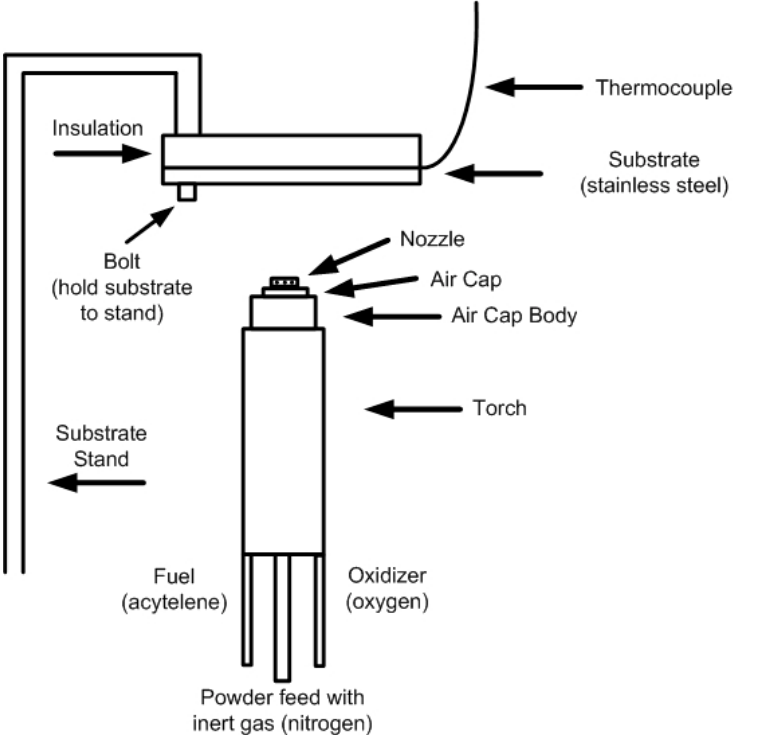
Figure 2. Schematic diagram of the experimental apparatus showing torch and target plate. Figure 3 illustrates post-test of target showing unburned aluminum deposits near center of torch jet projection. (white deposit appears to be alumina smoke, and surrounding black is soot from acetylene during